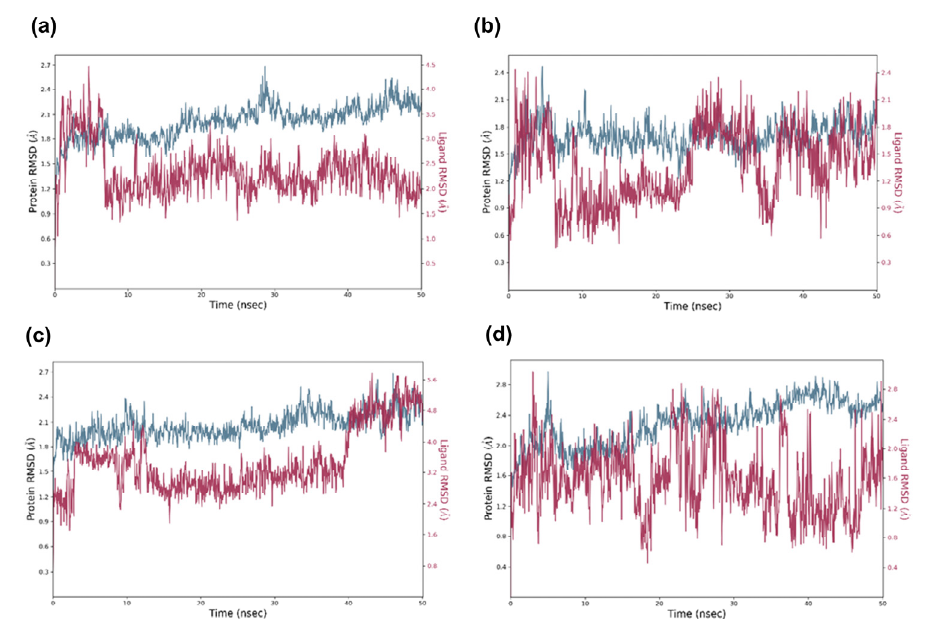
Figure 11. MD simulation trajectory (50 ns) analysis of the docked complexes via RMSD. In the time-dependent RMSD graph, C α -atoms of CDK6 complex with identified potential candidates, i.e., ( a ) candidate 1, ( b ) candidate 2, ( c ) candidate 3, ( d ) candidate 4. The CDK C α -atom RMSD is shown in blue, while the RMSD of candidates concerning CDK6 is shown in